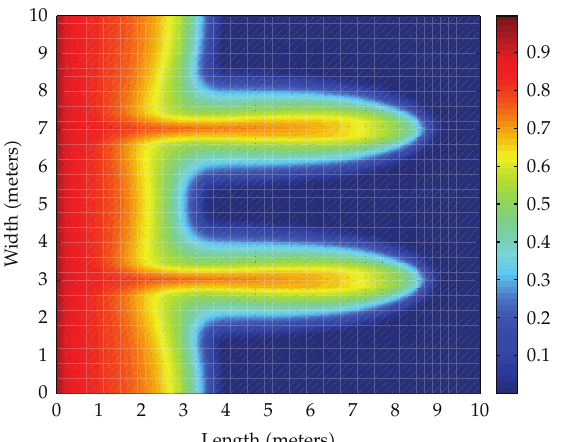
Figure 2: Water saturation profile at 0.35 PVI by the proposed method: Example